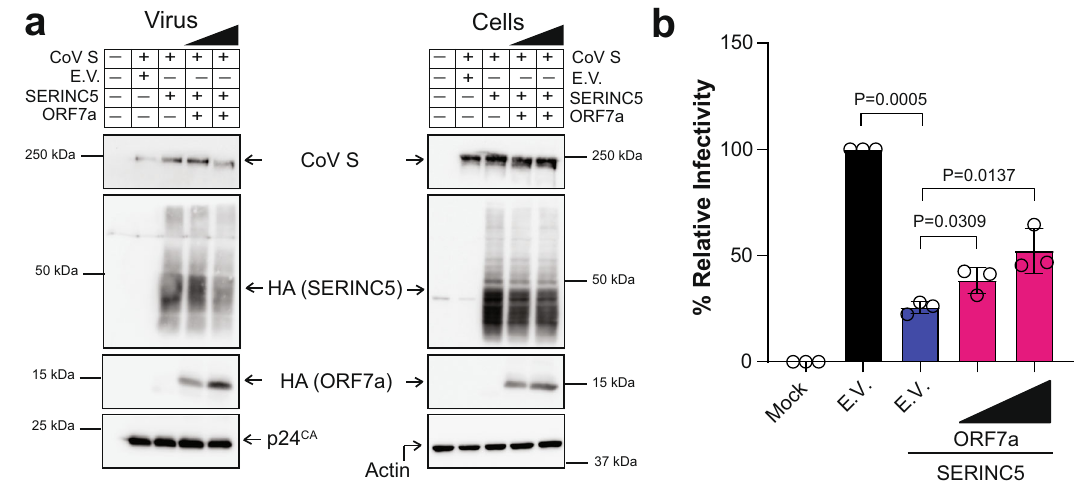
Fig. 9 SERINC5 restricts SARS-CoV S-mediated entry and is counteracted by SARS-CoV ORF7a. a SARS-CoV ORF7a is packaged in nascent virions and does not cause the degradation of SERINC5 or block SERINC5 incorporation in nascent virions. SARS-CoV S pseudovirus produced in the presence or absence of SERINC5 and SARS-CoV ORF7a was analyzed by immunoblotting. Representative immunoblotting results from n = 3 independent experiments are shown. Uncropped blots are in Source Data. b SERINC5 blocks SARS-CoV S pseudovirus infection and is counteracted by SARS-CoV ORF7a. 293T- hACE2 cells were infected with SARS-CoV S pseudoviruses produced in a . Luciferase levels were measured 48 hpi and normalized to p24 CA levels in the input pseudovirus. The percentage (%) of relative infectivity with respect to pseudovirus produced in the presence of empty vector is shown. Results are presented as mean ± SD from n = 3 independent experiments. Statistical signi fi cance was determined by one-sample t test (two-tailed) or unpaired t test (two-tailed). (empty vector, E.V.; SARS-CoV Spike, CoV S; SARS-CoV ORF7a,